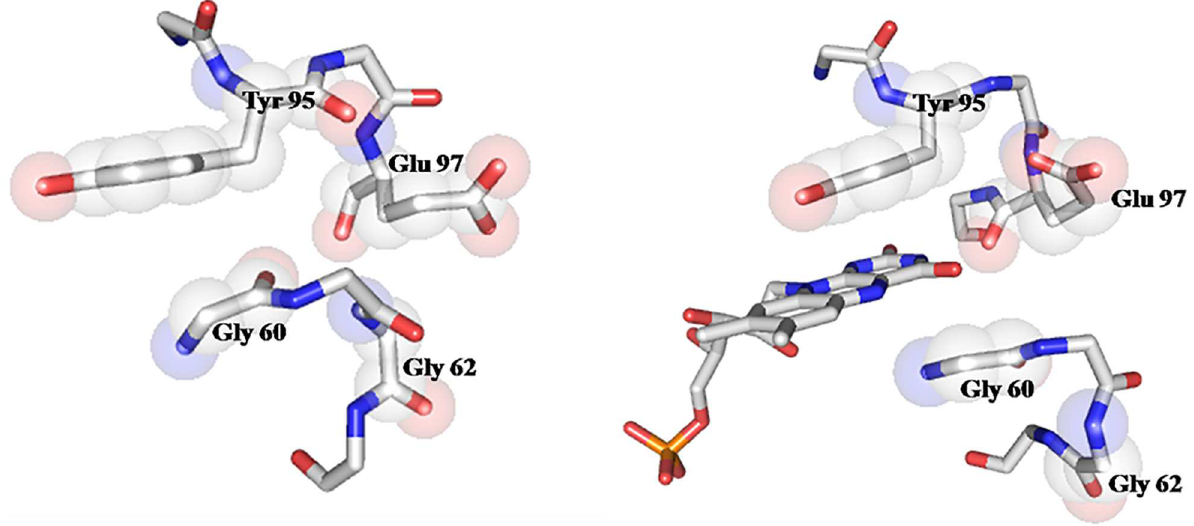
Fig 8. Stick representation of the FMN binding site in the Sp apo and holoflavodoxins indicating two key glycine residues (G60 and G62) that close the gap left by FMN in the apoprotein by interacting with residues of the 90’ loop: Y95 and E97.